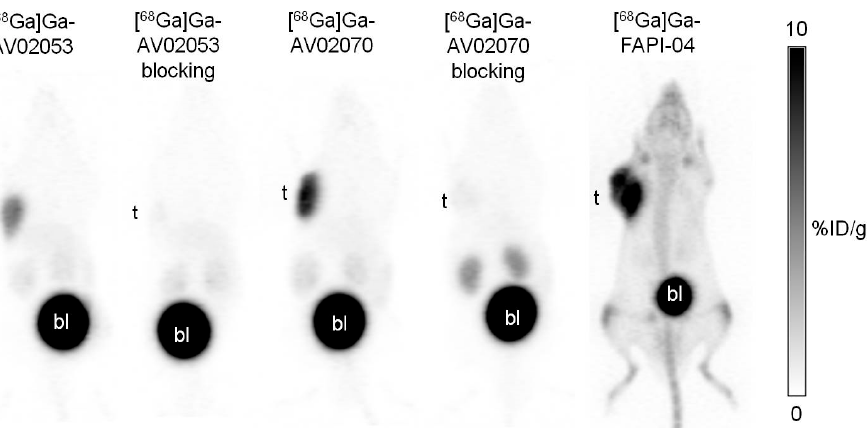
Figure 3. Representative maximum intensity projection PET images of [ 68 Ga]Ga-AV02053 and [ 68 Ga]Ga-AV02070 acquired at 1 h post-injection in mice bearing HEK293T:hFAP tumor xenografts. The image of [ 68 Ga]Ga-FAPI-04 has been reported previously [31], and is displayed here for comparison. Despite having lower tumor uptake, [ 68 Ga]Ga-AV02053 and [ 68 Ga]Ga-AV02070 showed better tumor-to-background contrast compared to [ 68 Ga]Ga-FAPI-04. The blocking with FAPI-04 decreased the tumor uptake of both [ 68 Ga]Ga-AV02053 and [ 68 Ga]Ga-AV02070 to background level. t: tumor; bl: urinary bladder.